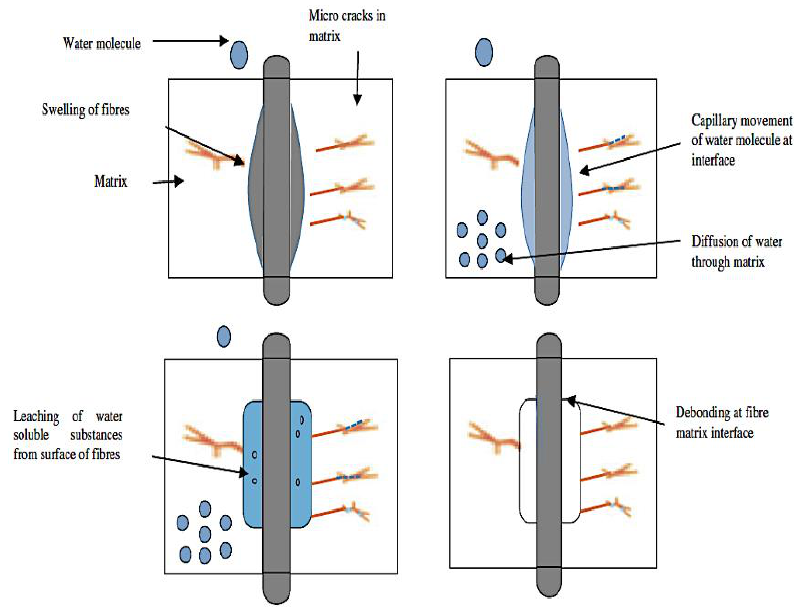
Figure 8. The sequences of NFRCs’ structural integrity loss caused by water absorption [120] (reprinted with permission from SAGE Publications, Licence Number:5446970811502).